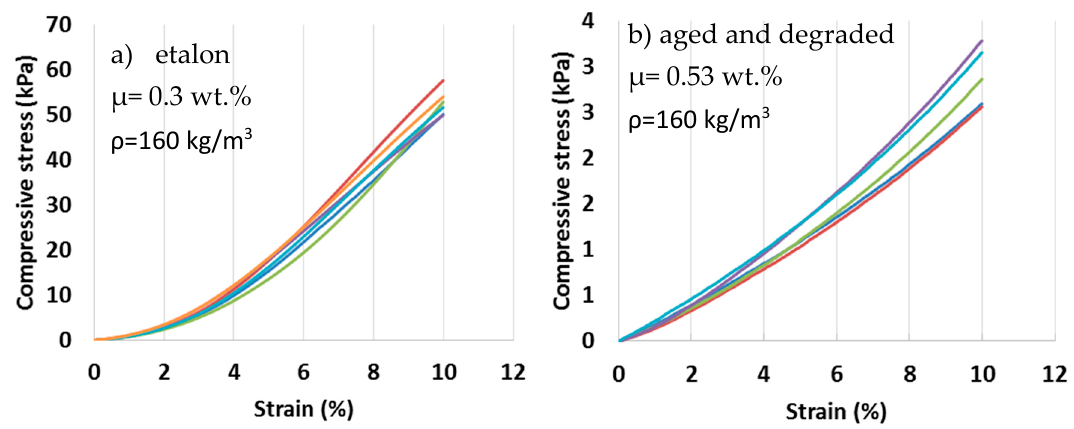
Table 1. Water content ( u ) and compressive strength ( σ ) of degraded mineral wool from basalt fibers.